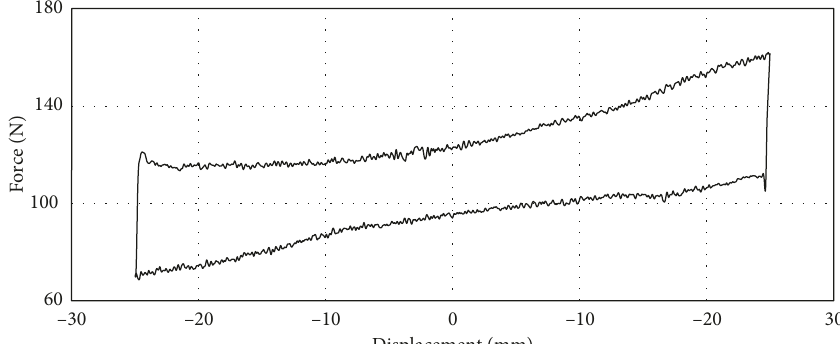
Figure 2: Quasistatic force-displacement cycle of the MR damper (3 hours per cycle).